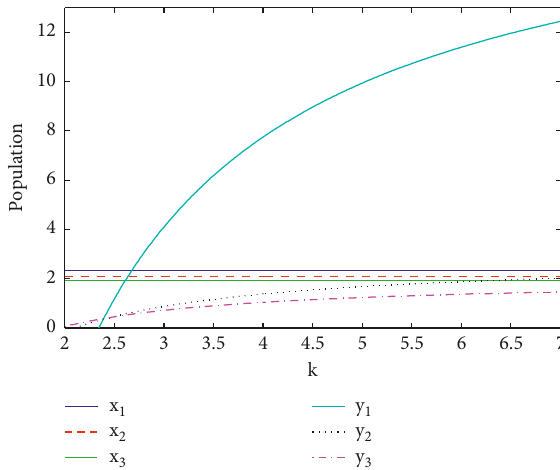
Figure 3: Behaviour of all species with respect to k